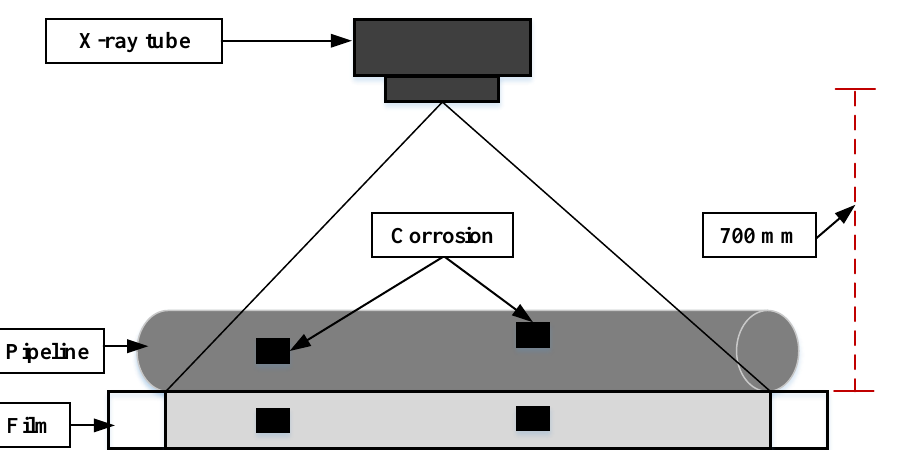
Figure 12. Schematic framework of radiography setup for corrosion detection and monitoring [93].